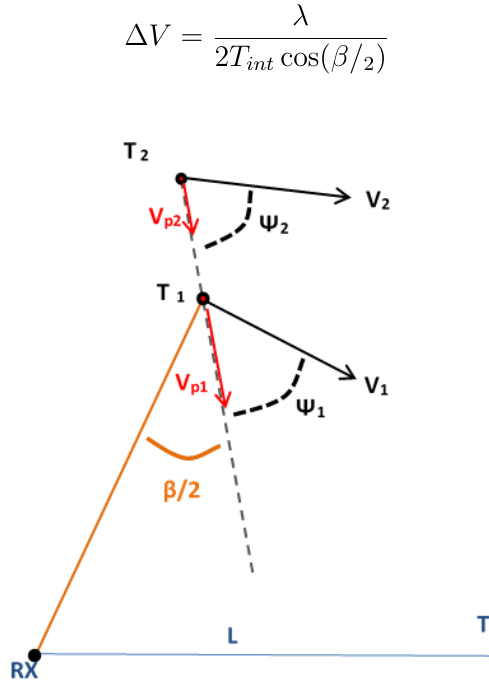
Figure 5. Geometry for Doppler resolution